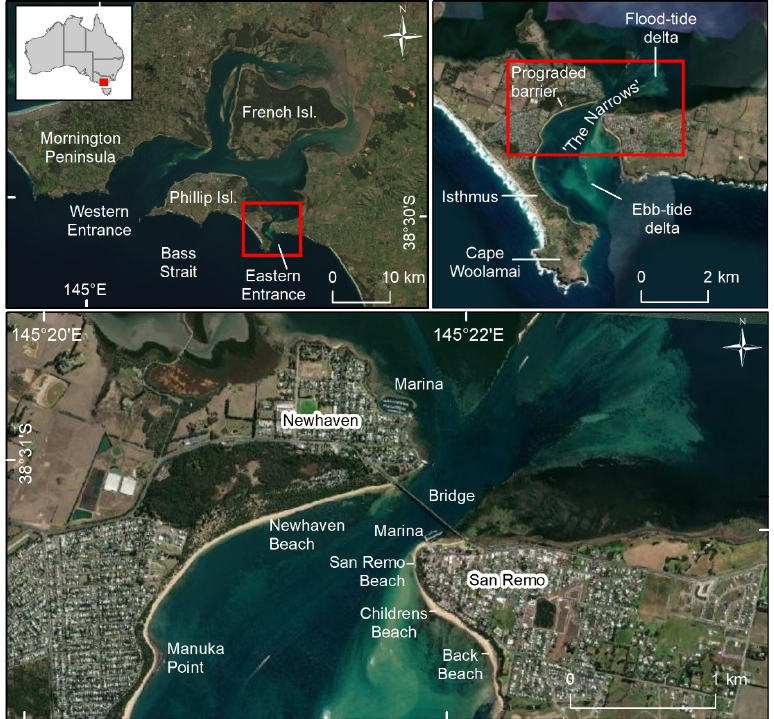
Figure 1. Study sites of San Remo and Newhaven located on the Eastern Entrance of Western Port, Victoria. A rocky seawall runs along the entire length of San Remo Beach and Childrens Beach. Important features described in the text are labelled. Basemap imagery from ArcGIS Online. Water passing through the Eastern Entrance contributes to about 15% of the volume entering WP in any tidal cycle [40]. This inwards circulation causes some incursion of sand forming a small flood-tide delta to the north of the bridge [42], which led Marsden [43] and Marsden et al. [35] to infer a flood-dominant circulation and sediment transport through the entrance. However, uncertainty remains, as other studies [41,44,45] indicate an ebb-dominant circulation pattern [39]. This has been corroborated by the existence of a sandy ebb-tide delta and sandy beaches mainly observed downstream of the bridge, sug- gesting that marine sands from offshore sources and weathered Pleistocene aeolianites are not transported in large amounts inwards.